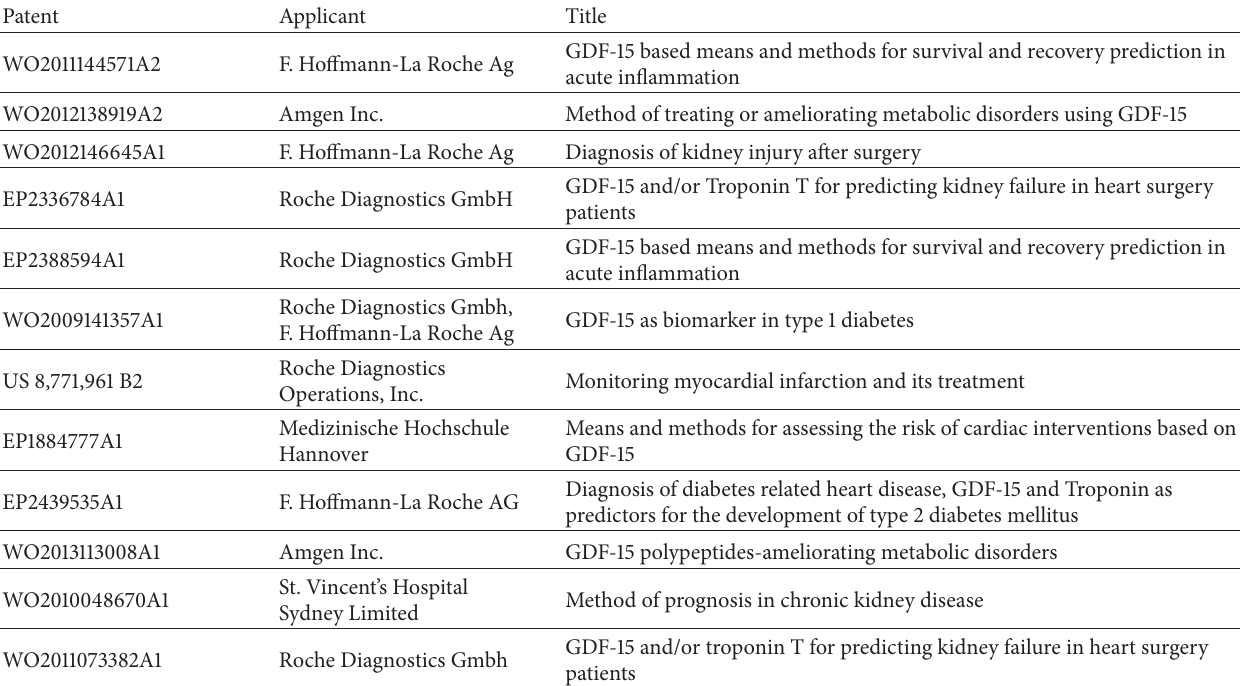
Table 3: GDF-15 patents related to diabetes, cardiovascular diseases, and chronic kidney